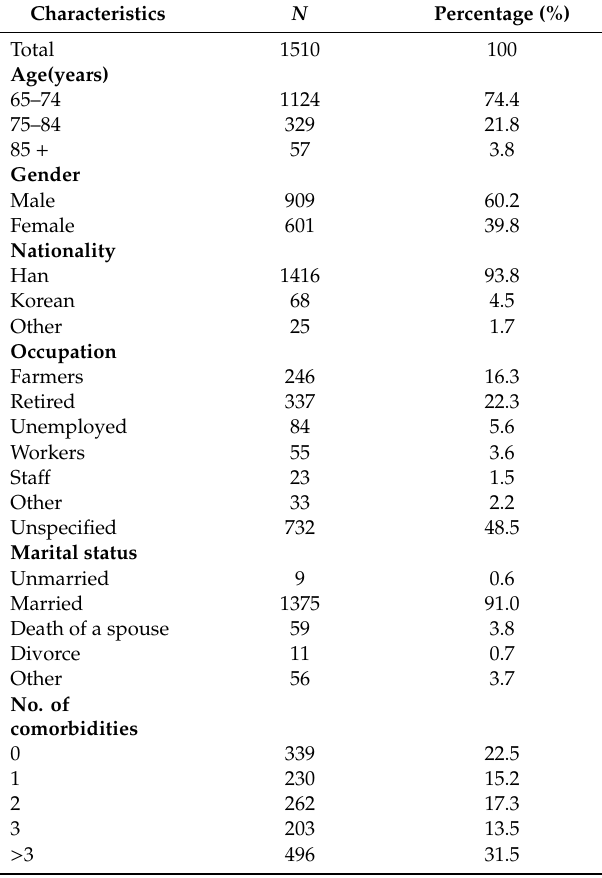
Figure 1. ( a ) Distribution (blue) of the number of comorbidities across all patients, where the x-axis represents the number of patients having n comorbidities ( 0 ≤ 𝑛 ≤ 9 ) and the cumulative proportion distribution across all patients (orange). ( b ) Distributions of the numbers of comorbidities for men and women.